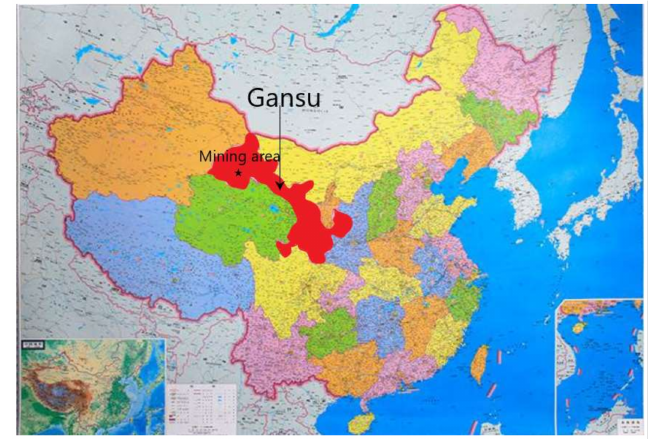
Figure 1. Location map of mining area.